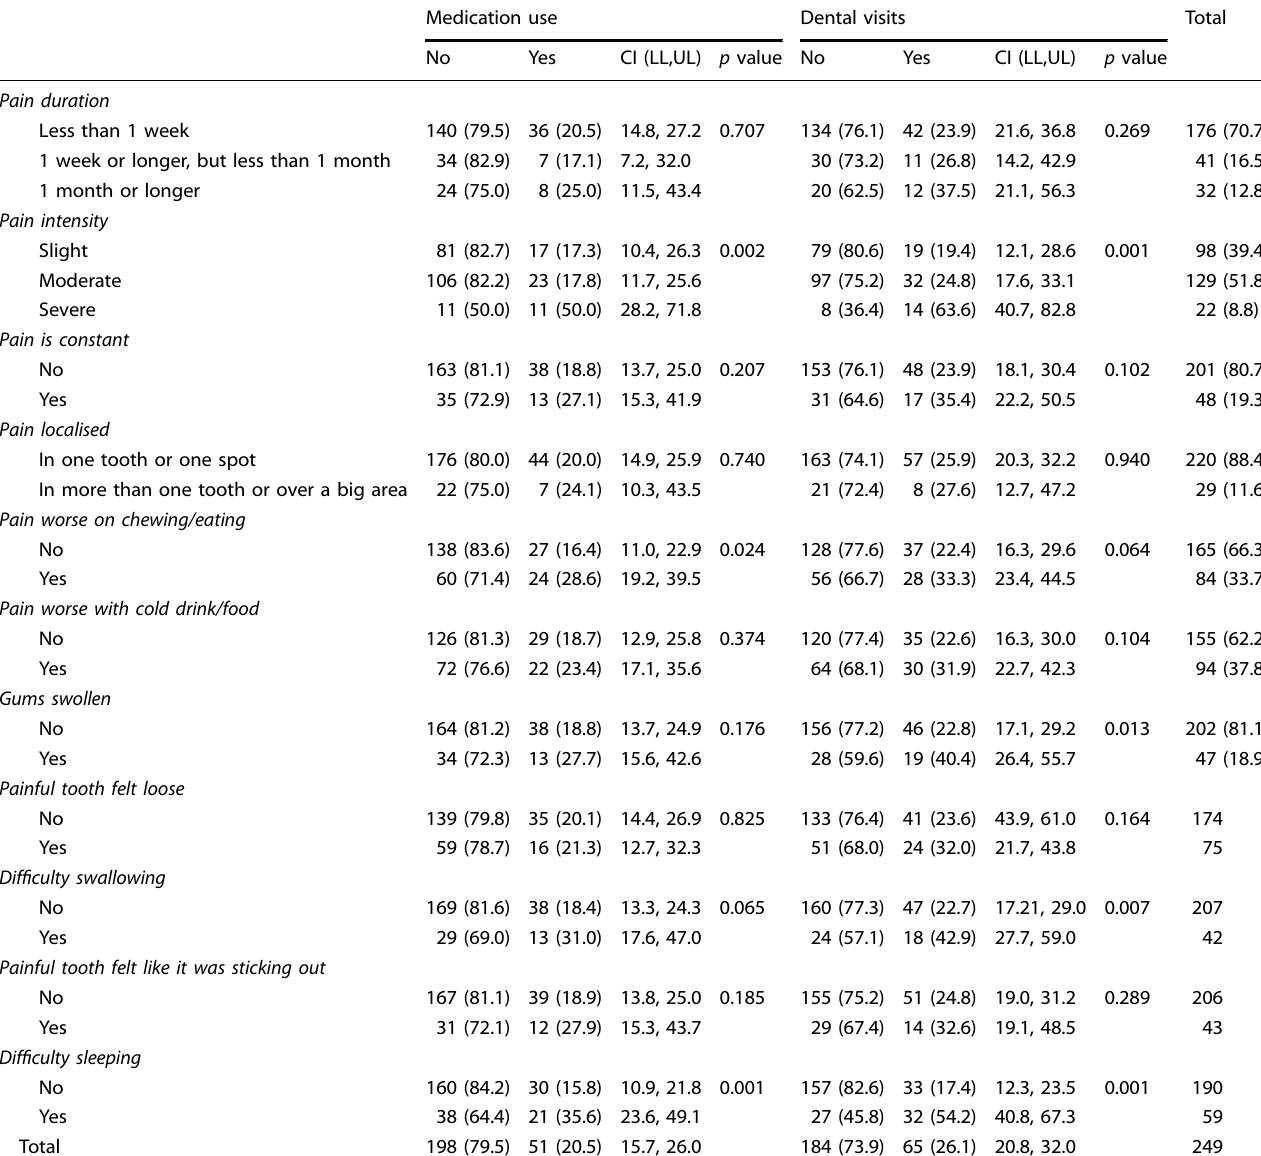
Table 3. Number (%) of students who had taken medicine and visited a dentist for tooth pain in the past 1 month, distributed by pain